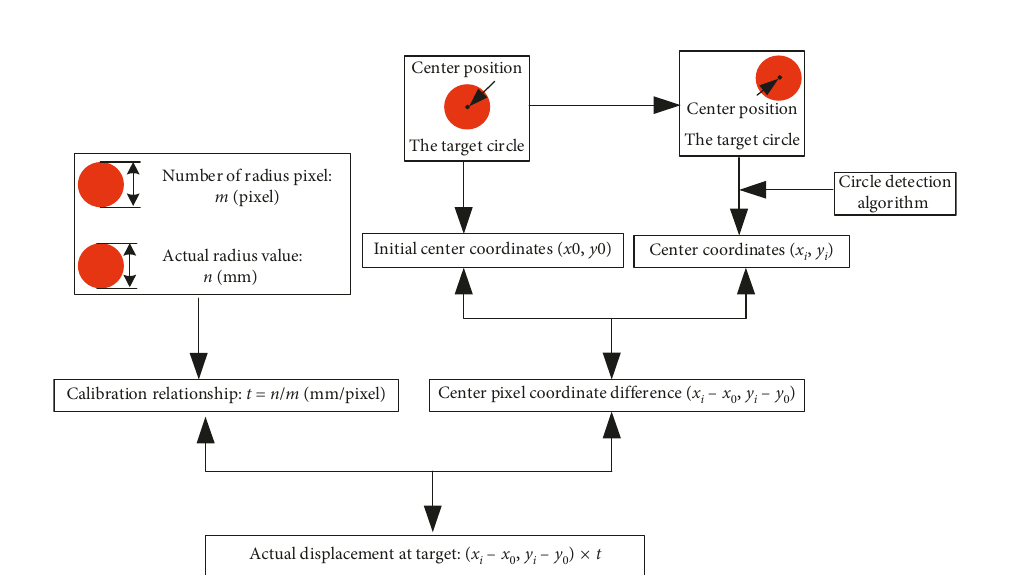
Figure 3: Schematic diagram of the algorithm